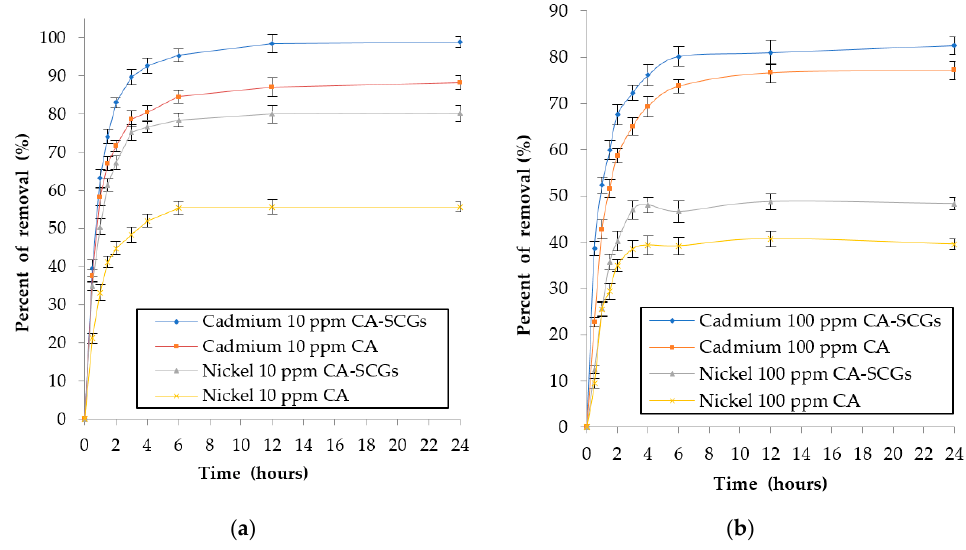
Figure 12. Plots of percent of removal of metal vs. time: ( a ) initial concentration of 10 ppm of metal and ( b ) initial concentration of 100 ppm of metal.